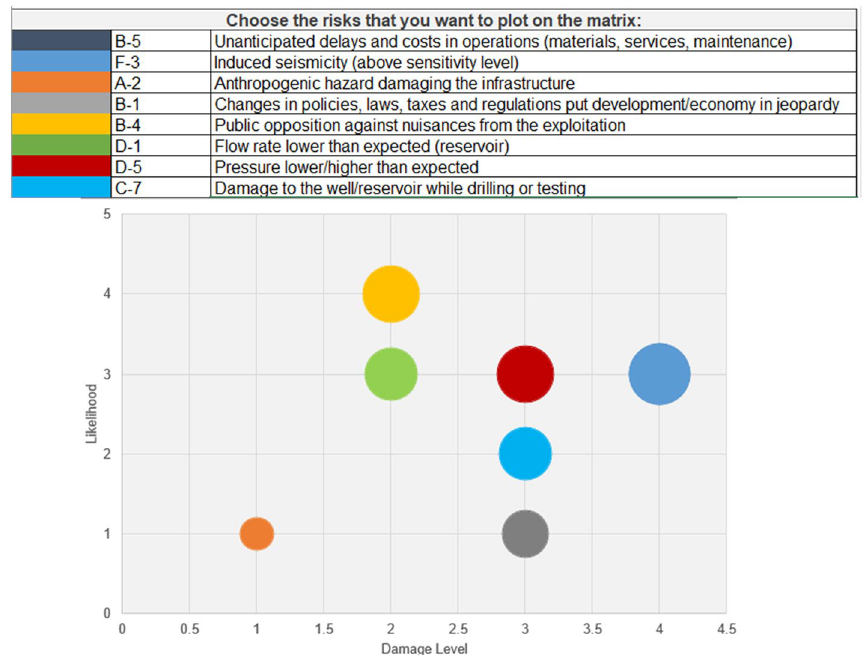
Fig. 9 Matrix dot plot showing the risks related to induced seismicity risk for the URG case. Size of point is representative of the risk index (likelihood